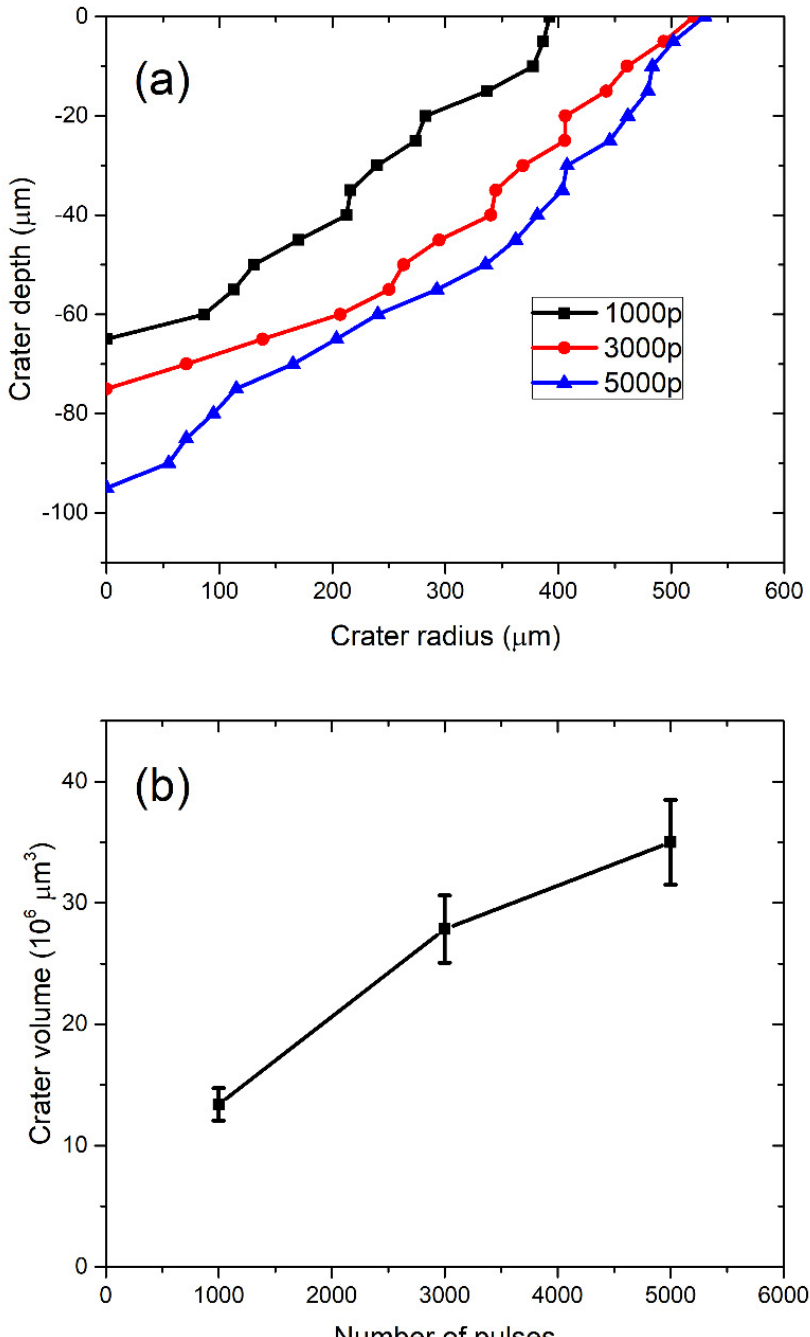
Figure 3. ( a ) Profiles of craters remained on the Ti target after ablation and ( b ) ablation crater volume dependence on the number of pulses.